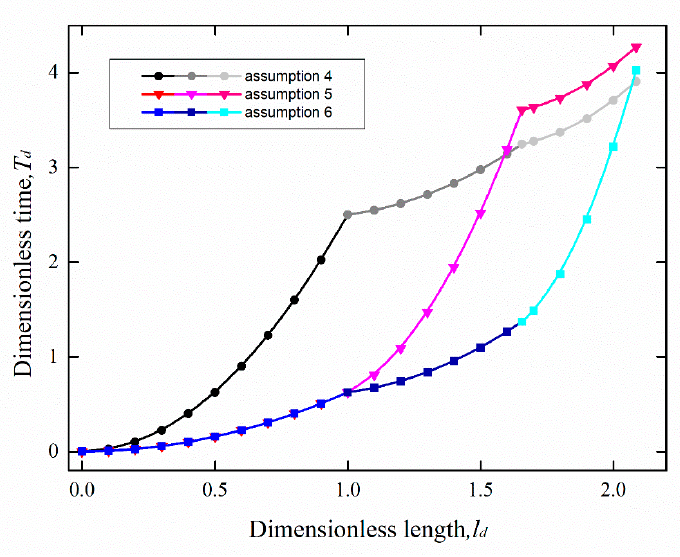
Figure 8. Dimensionless time varies with the distance of fluid flow in the second group of realizations.